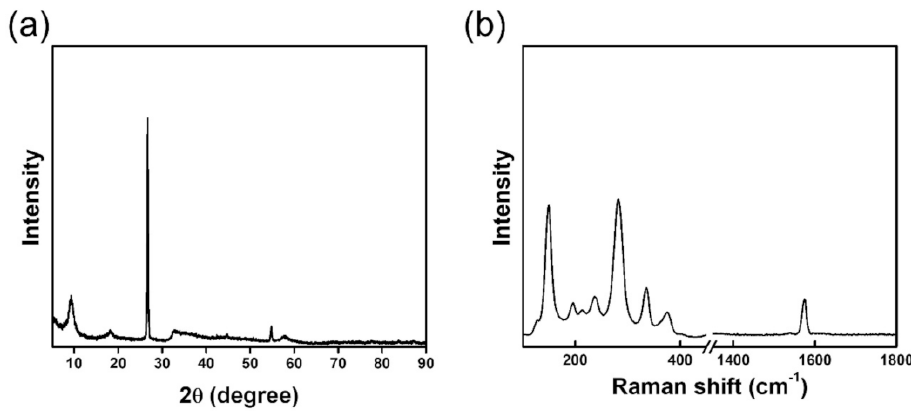
Figure 1. ( a ) XRD patterns and ( b ) Raman spectrum of 1T-MoS 2